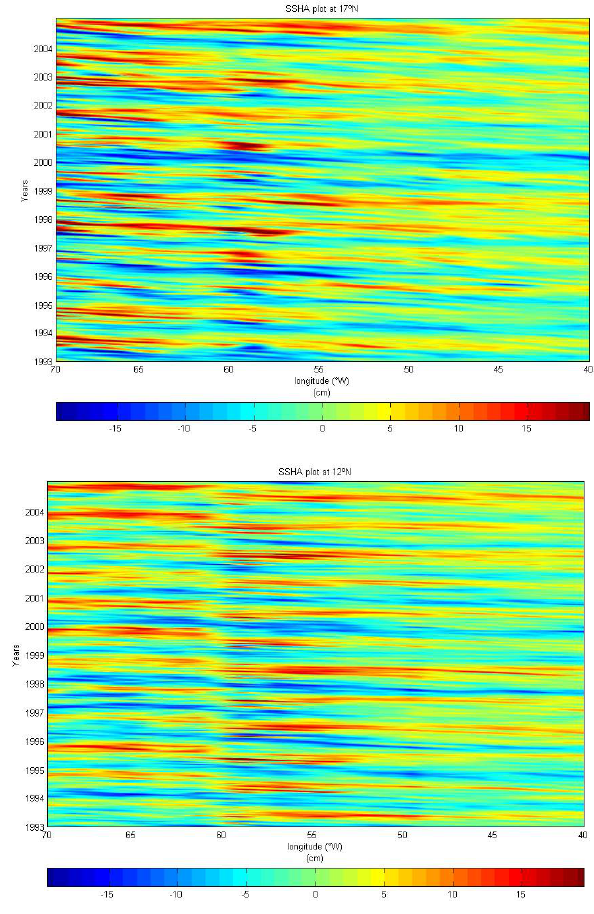
Figure 4. Hovmöller diagrams of SHA at 17ºN (top) and at 12ºN (bottom) before Fig. 4. Hovm¨oller diagrams of SHA at 17 ◦ N (top) and at 12 ◦ N filtration. (bottom) before filtration.